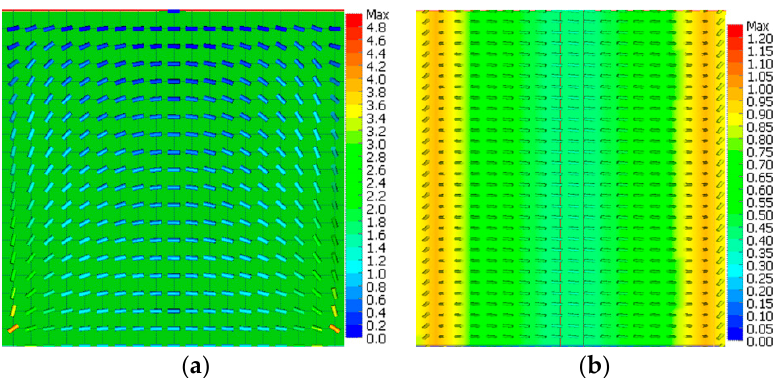
Figure 3. Simulated ( a ) cross section and ( b ) top view of the LC director across the nematic LC microlens at V on = 4.8 V rms .